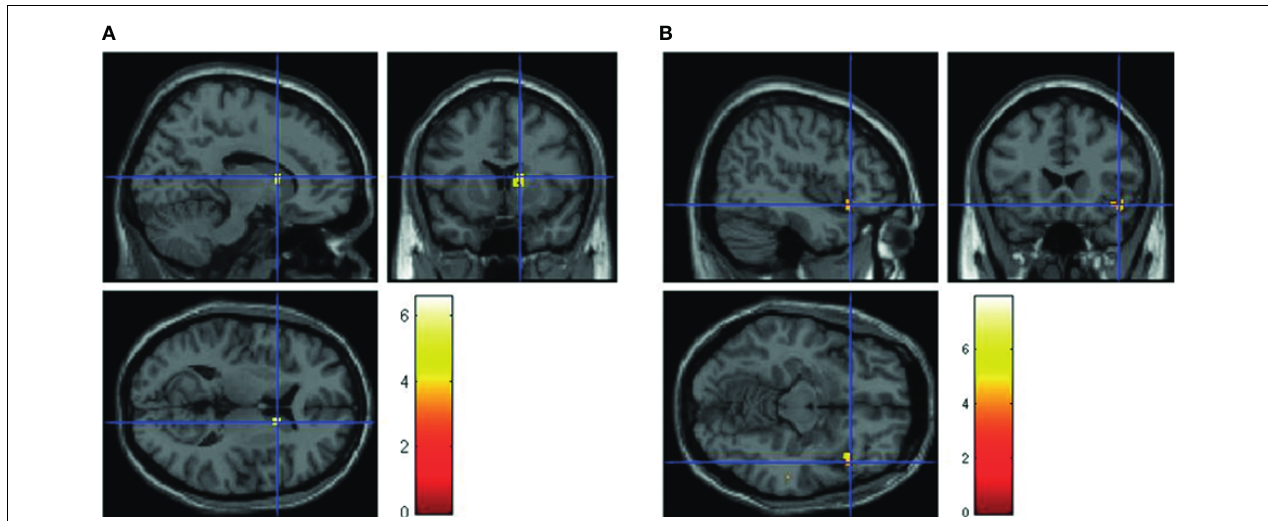
FIGURE 6 | Main effect of falsehood-eliciting question (QuestionType B) on response type. The peak activations are in (A) the right caudate (14 12 10) and (B) right inferior frontal gyrus (IFG; 42 20–12), p < 0.005, uncorrected.The color-bar corresponds to T